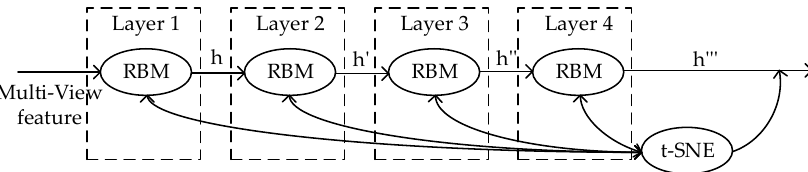
Figure 4. Schematic diagram of t-SNE adjusted the RBM pre-training network.